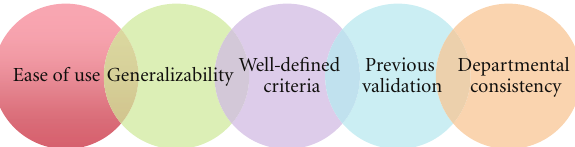
Figure 1: Components of a Well-Developed Advanced Nursing